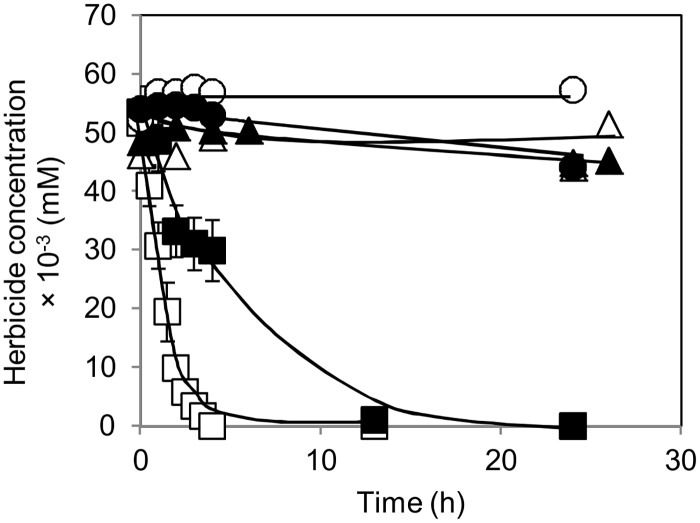
Herbicide biodegradation by ammonium-grown Arthrobacter aurescens TC1.The bacterium cells were grown in medium with 2.8 mM nitrogen from ammonium. It is represented the time-course (in hours, h) variation curves of terbuthylazine (■, ●, ▲) or atrazine (□, ○, △) concentration in the supernatant of phosphate-salt buffer (pH 7) supplemented with each herbicide (initial concentration ~ 0.05 mM) and inoculated at time zero with the bacterium cells (■, □) or with cells killed by boiling (▲, △), or non-inoculated (●, ○). Error bars represent ± 1 standard deviation.